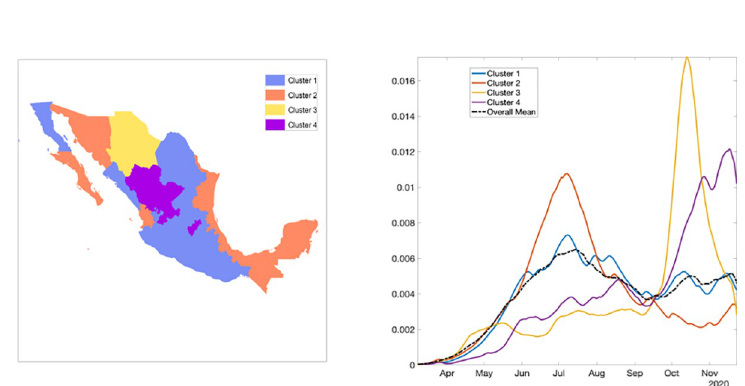
Fig 11. Clusters of states by their growth rates. Cluster 1 in blue, cluster 2 in orange, cluster 3 in yellow, and cluster 4 in purple. The right panel shows the average growth rate curves for each cluster (solid curves) and their overall average (black broken